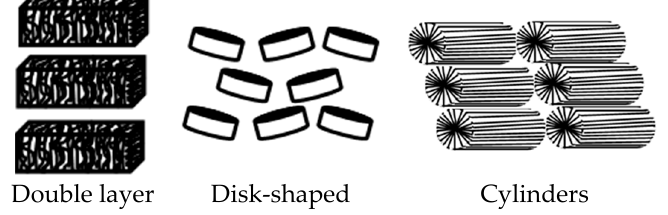
Figure 3. Examples of geometrical models of mesophases formed in surfactant solutions.